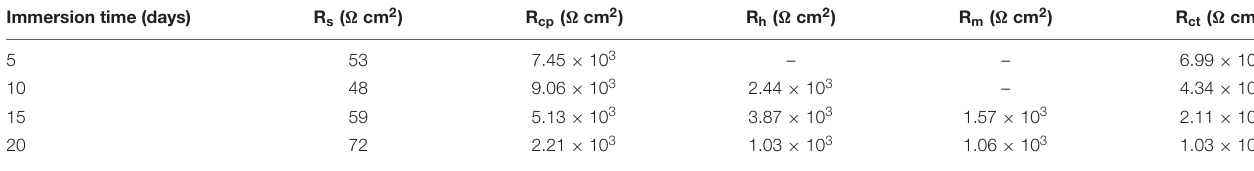
FIGURE 9 | Nyquist (A) and Bode (B) plots of immersed MAO-ED coating samples in SBF. TABLE 5 | Fitting EIS data of MAO-ED samples in SBF after different immersion